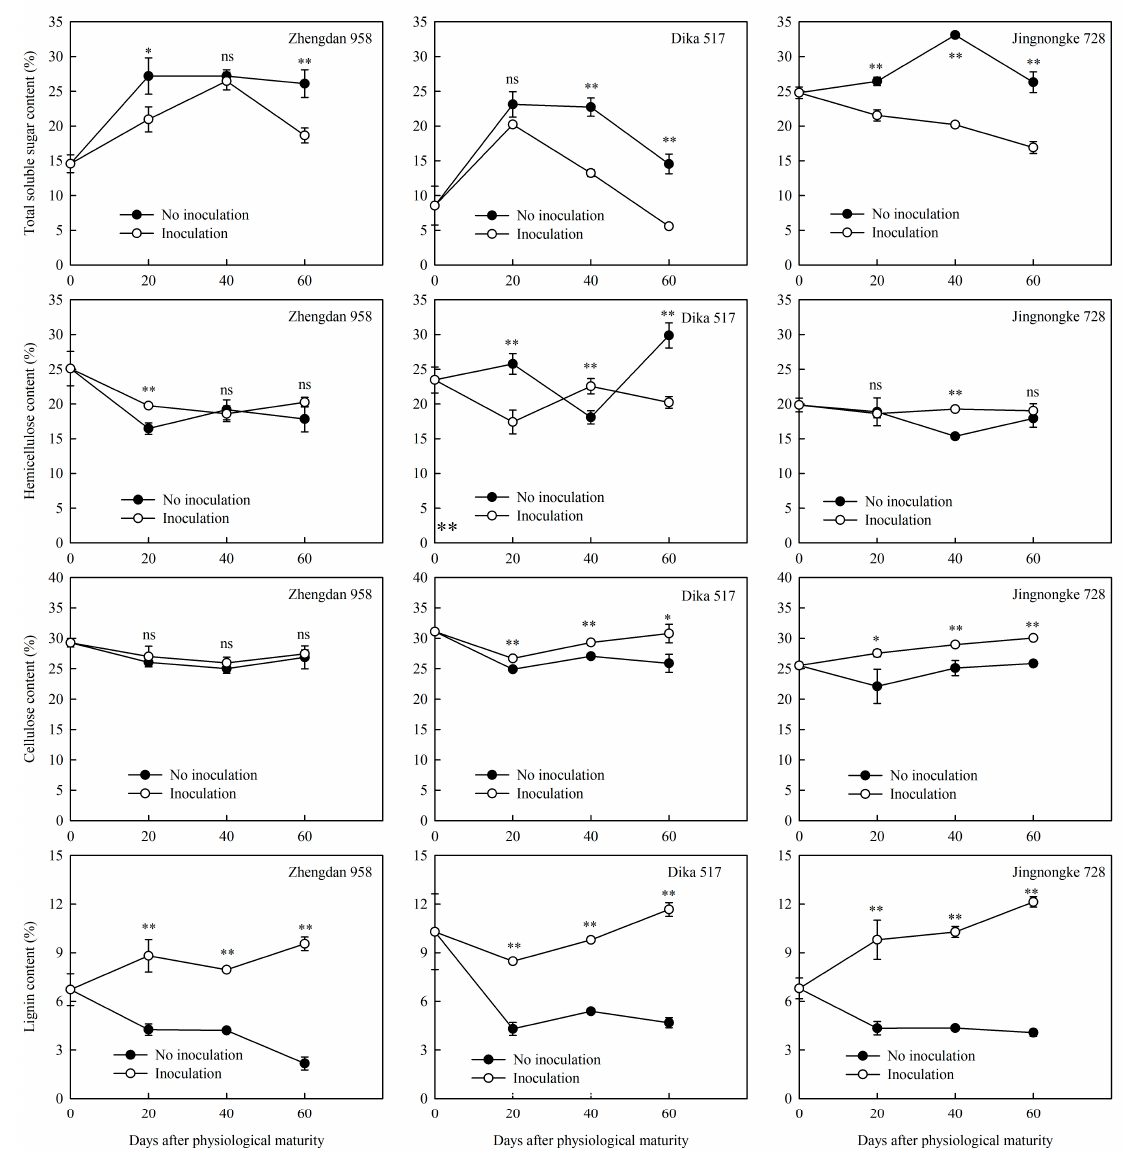
Figure 10. Internode carbohydrates after physiological maturity of different maize cultivars with an inoculation of Pythium aristosporum (2018). * and ** represent significant differences between inoculation and no inoculation treatments at 0.05 and 0.01 levels, respectively, “ns” represent no significant difference.